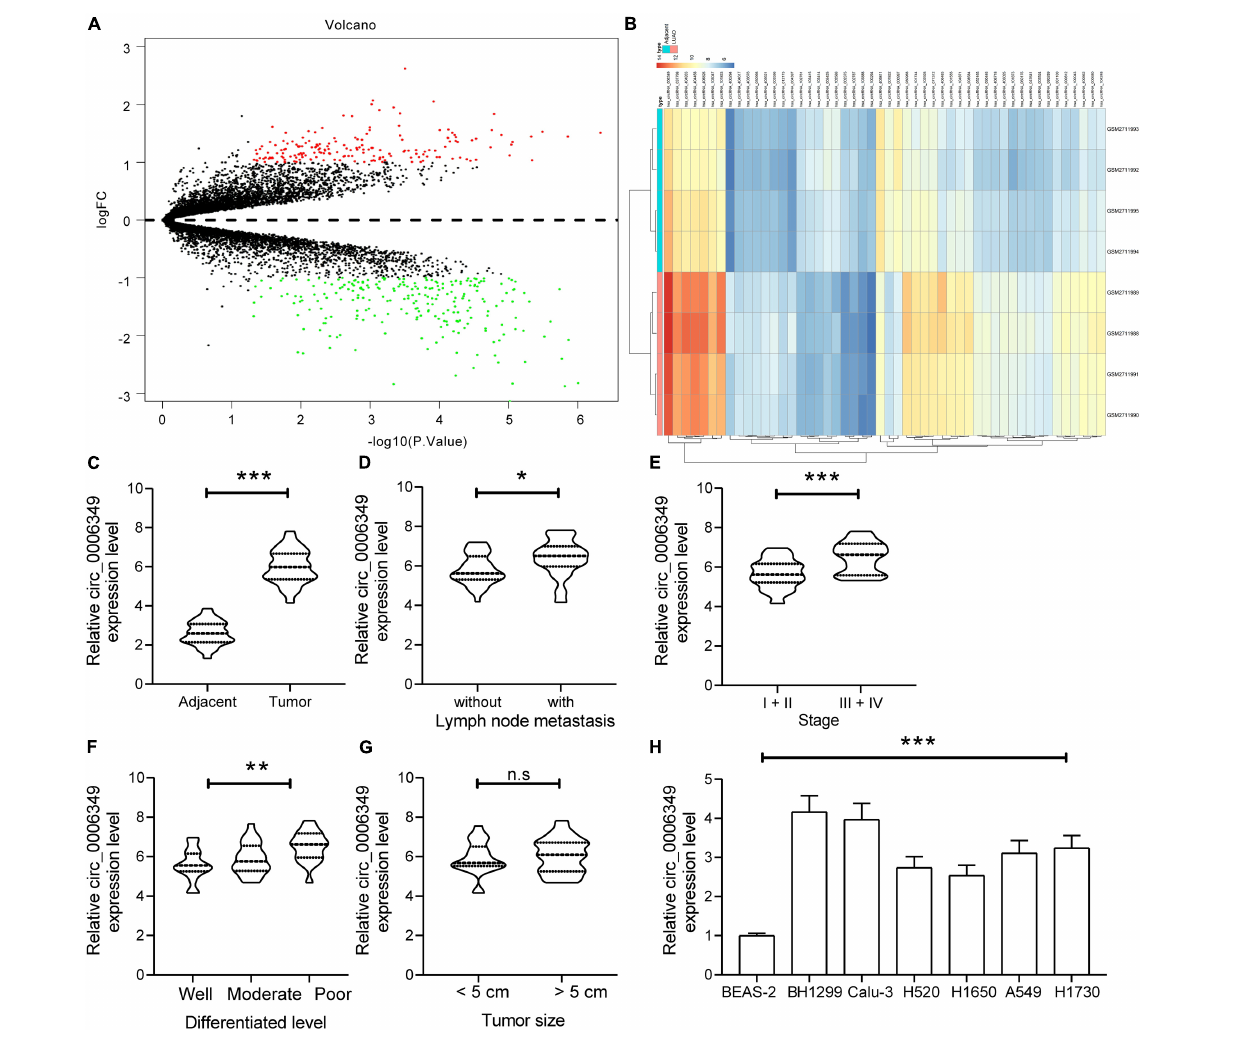
FIGURE 1 | Circ_0006349 is highly expressed and indicates dismal prognosis in patients with non-small-cell lung cancer (NSCLC). (A) A volcano map for circRNAs screened out from the NSCLC GSE101684 dataset; (B) a heatmap for top 50 differentially expressed circRNAs in the GSE101684 dataset; (C) circ_0006349 expression in tumor and normal tissues from 59 patients with NSCLC determined by reverse transcription quantitative polymerase chain reaction (RT-qPCR); (D–G) relevance between circ_0006349 expression with the lymph node metastasis, tumor stage, tumor differentiation and tumor size in patients; (H) circ_0006349 expression NSCLC cell lines (A549, H1299, Calu-3, H520, H1650, and H1730) and in BEAS-2B cells detected by RT-qPCR. Differences were compared by paired t test (C) , unpaired t test (D–G) , or one-way ANOVA (H) . All data were presented as the mean ± SD from three independent experiments. * p < 0.05; ** p < 0.01; *** p < 0.001; n.s, no